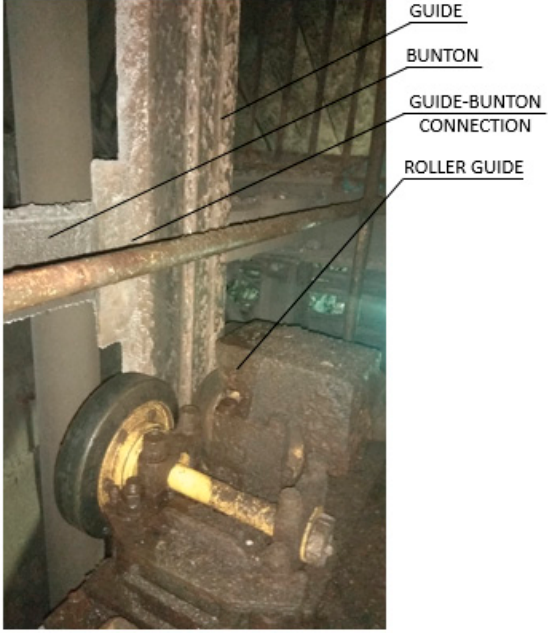
Figure 4. Connection between the guide and the bunton and guide roller.